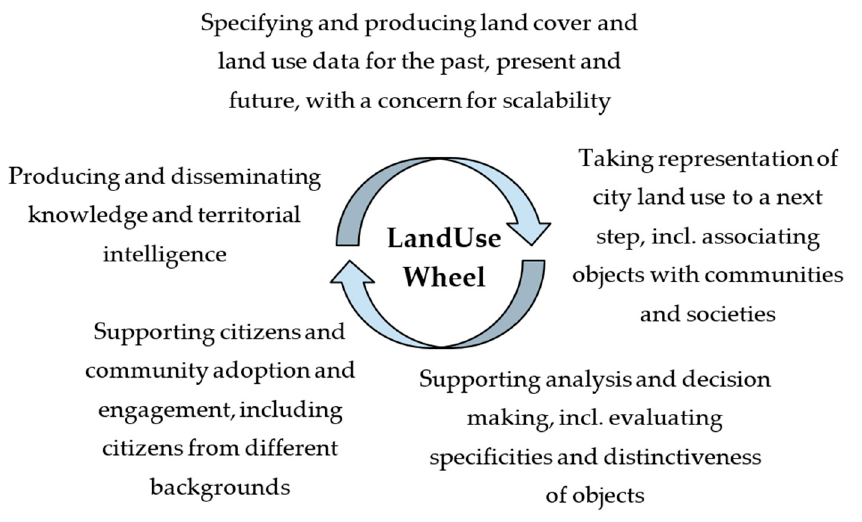
Figure 2. Our proposed LandUseWheel symbolizes the life cycle of information, data and knowledge related to land use. This circle only portrays the high-level functionalities that are detailed in Table 1.